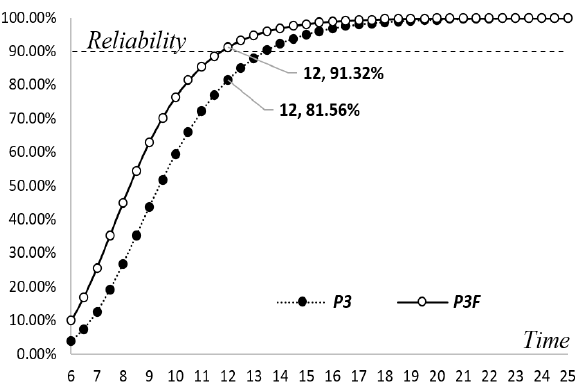
Figure 10. Expected Reliability for the Former and the New Alternatives.